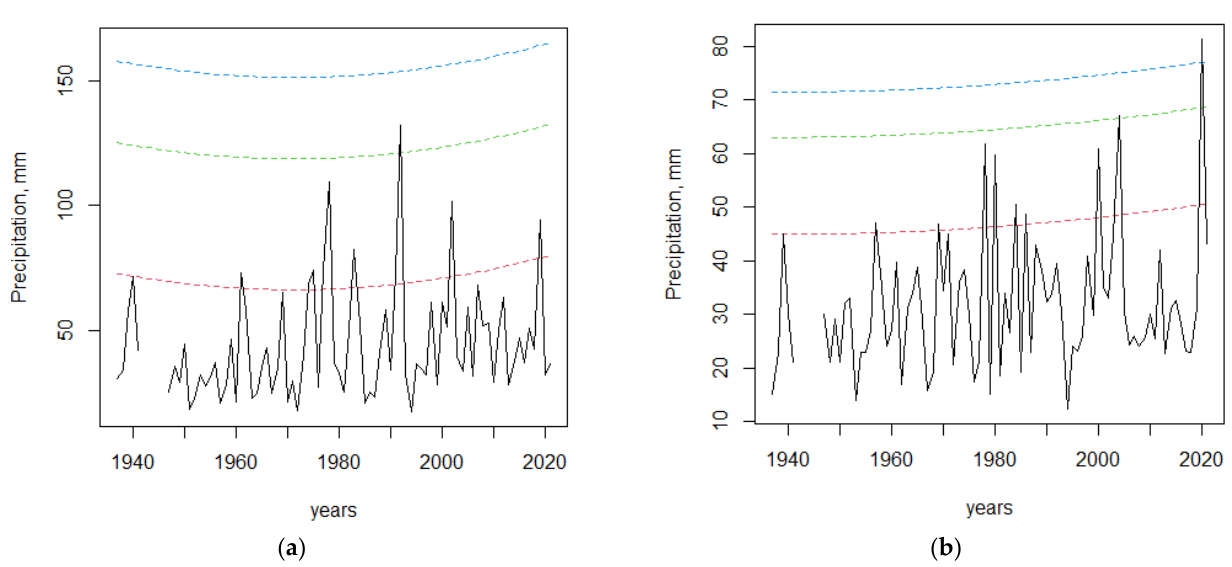
Figure 5. Interannual variability of MADP and non-stationary estimates of MADP of different return periods for stations Feodosiya ( a ) and Hersonesskij mayak ( b ). Dashed lines of red, green, and blue color represent non-stationary estimates of MADP for return periods of 10, 50, and 100 years, re- spectively.